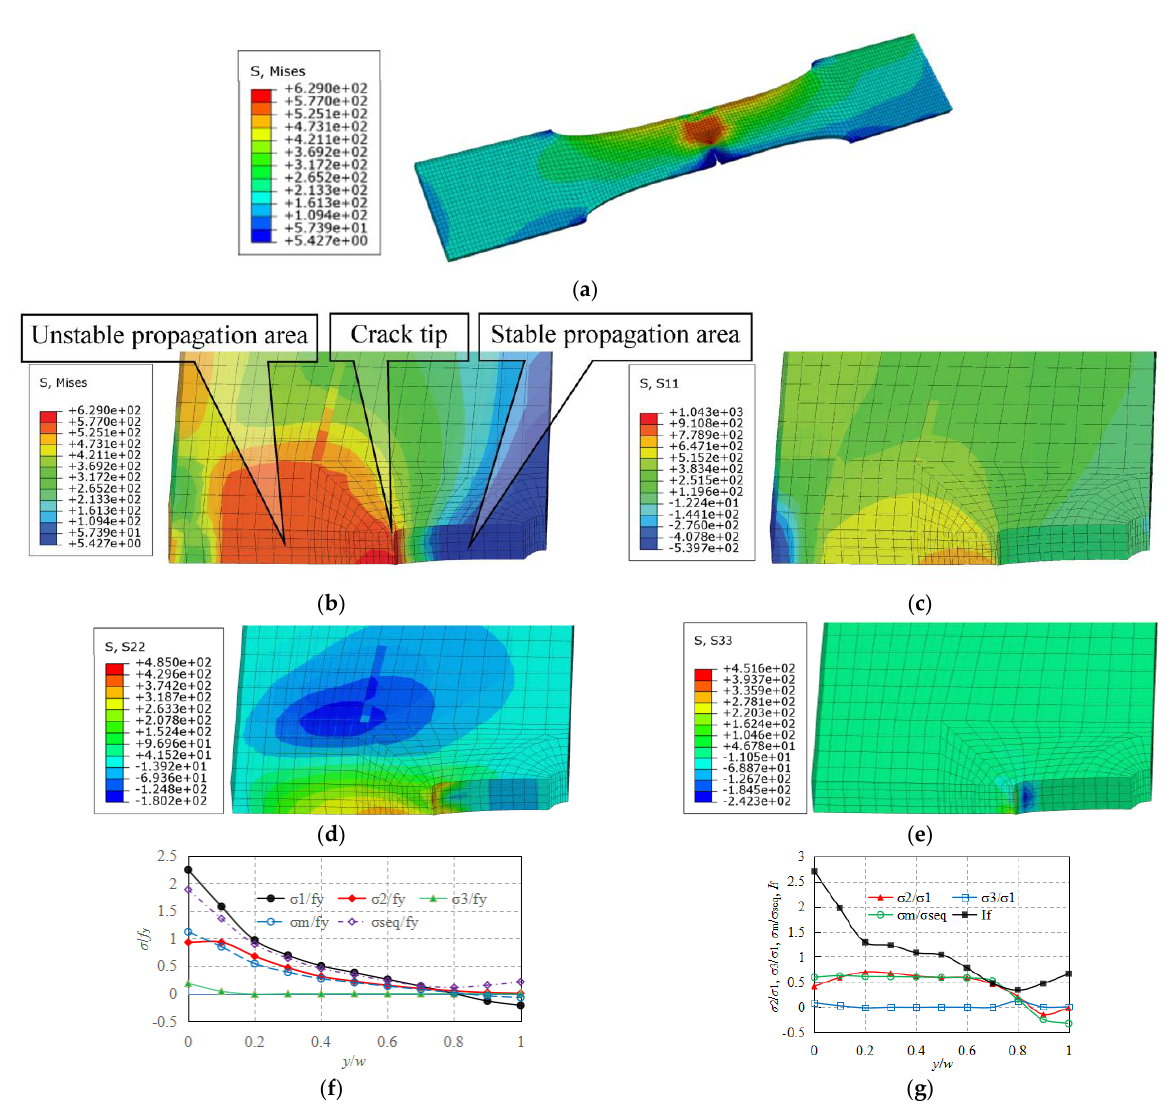
Figure 6. Numerically calculated stress field of specimen B1. ( a ) Overall equivalent stress, ( b ) equivalent stress, ( c ) the first stress σ 1 , ( d ) the second stress σ 2 , ( e ) the third stress σ 3 , ( f ) the distribution of relative stress, ( g ) the distribution of stress ratio and I f.